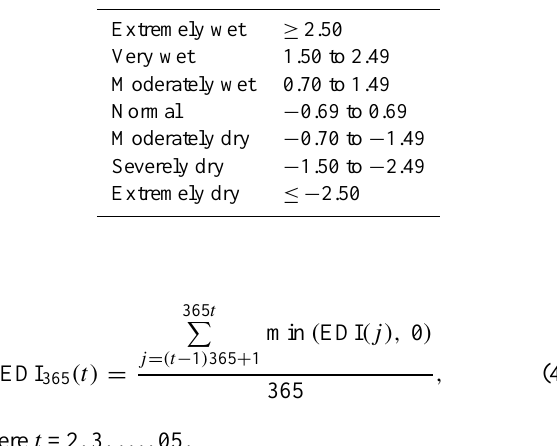
Table 1. Drought severity classification by the EDI index (Morid et al.,